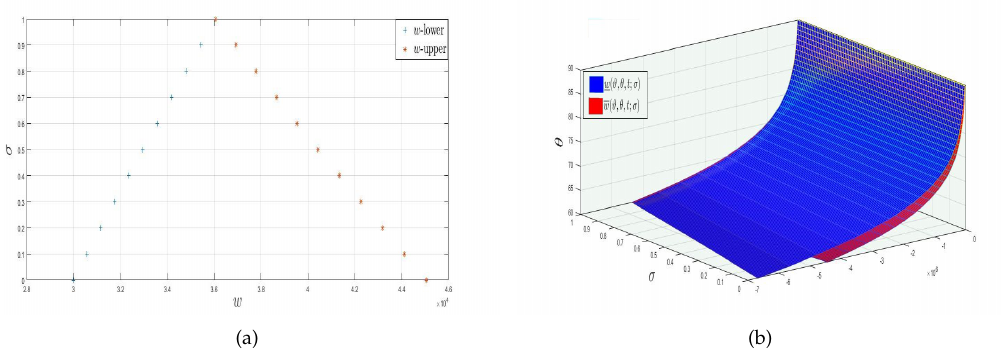
Figure 2. The exact lower and upper solutions of Equation (145) at ϑ = 60, θ = 90, t = 200, ρ = 1, n = 2. ( a ) 2 D figure for exact solution of fuzzy ZK ( 3,3,3 ) equation of w in Example 6. 1923; ( b ) 3 D figure for exact solution of fuzzy ZK ( 3,3,3 ) equation of w in Example